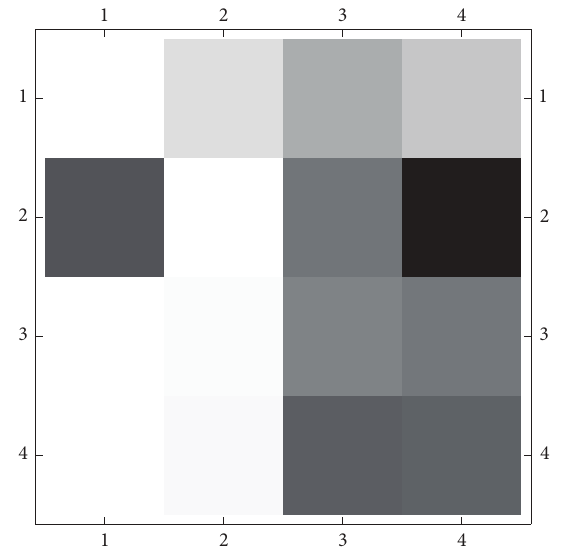
Figure 3: In this figure we use a grayscale to represent the level of contagion from cluster in column 𝑗 to cluster in row 𝑖 ( 1 ≤ 𝑖 , 𝑗 ≤ 4 ) (the darker the more